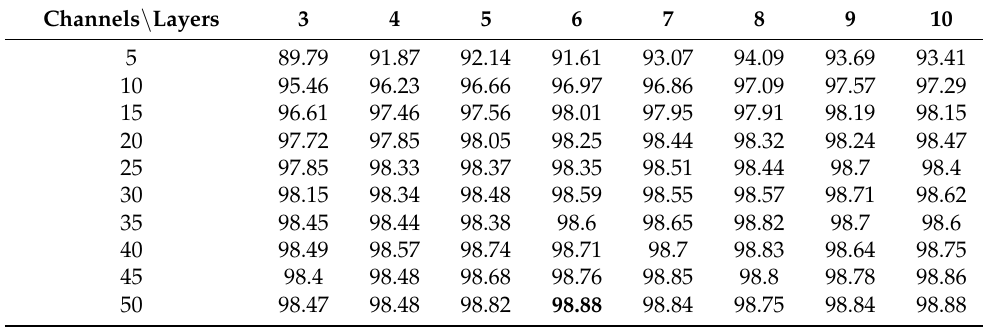
Table 3. GPU accuracy estimation